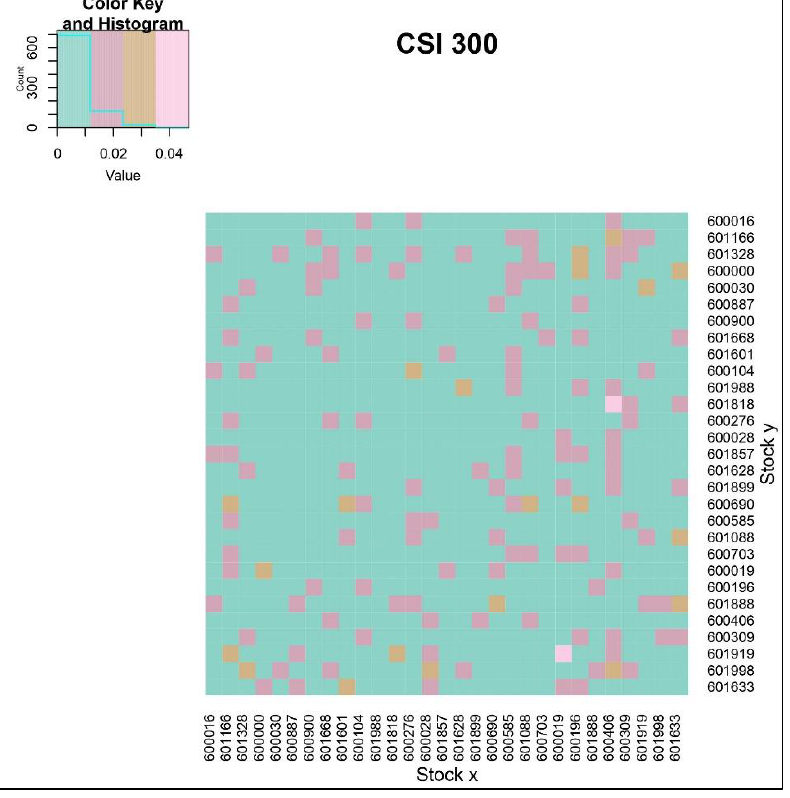
Figure 4. The information flow (effective transfer entropy) from stock y to stock x, for the top companies (by market capitalization) in the CSI market, after the COVID-19